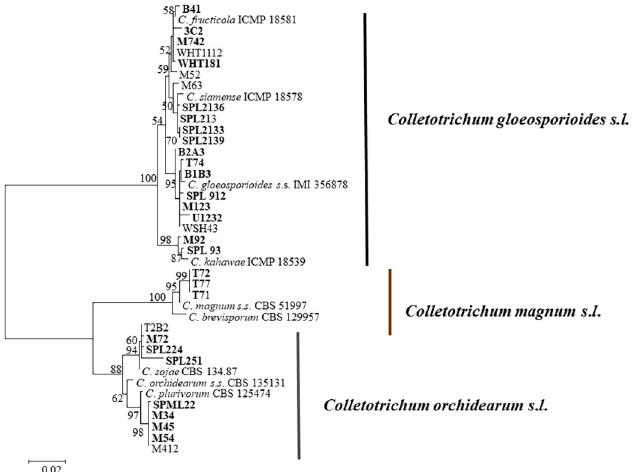
Fig 3. A maximum likelihood phylogenetic tree based on ITS, and TUB2 sequences from 32 isolates from OLA and representative isolates of the different Colletotrichum species complexes. Bootstrap values � 50% are shown at the nodes. The isolates selected for further phylogenetic analysis are shown in bold. The scale bar indicates 0.02 substitutions per